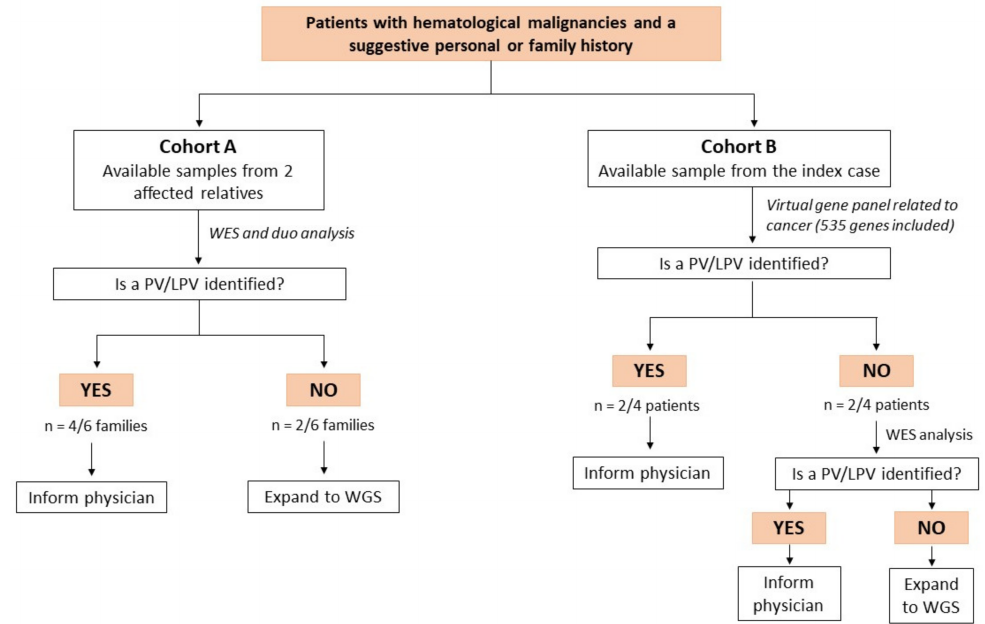
Figure 1. Algorithm for the detection of germline variants predisposing to inherited forms of hematological malignancies. Abbreviations: PV: pathogenic variant, LPV: likely pathogenic variant, WGS: whole genome